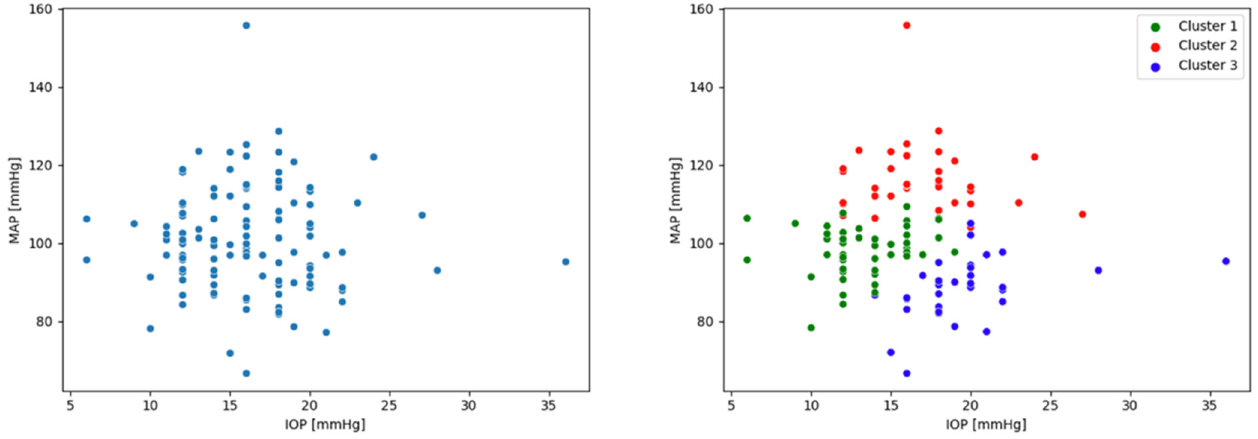
Figure 3. In both graphs, each dot represents a patient in the IGPS, plotted with respect to IOP and mean arterial pressure (MAP). On the right, patients are colored according to the label assigned to them by the fuzzy C-means algorithm applied to the enhanced dataset. The physiology-informed machine learning approach was able to quantify relative contributions of IOP and blood pressure to OAG risk for patients in these